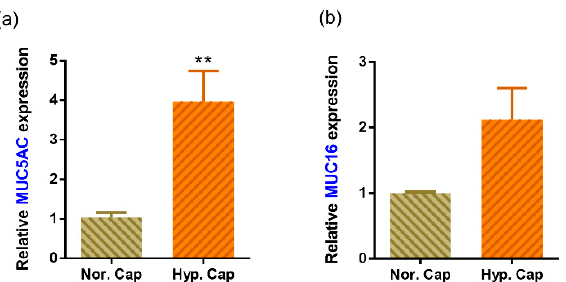
Figure 6. Effect of hypercapnia on the expression of mucins in human corneoscleral rim explant cultures. Graphs indicate mean relative mRNA expression of MUC5AC ( a ) and MUC16 ( b ) in matched corneoscleral rims following exposure to either 5% CO 2 (normocapnia—Nor. Cap) or 20% CO 2 (hypercapnia—Hyp. Cap), in vitro for a period of 24 h. The expression of MUC5AC and MUC16 was normalised to expression of β -actin (housekeeping gene). The bar graph indicates mean ± SEM from two technical replicates for each of the three biological replicate experiments. ** p < 0.01; two-tailed paired sample t -test.